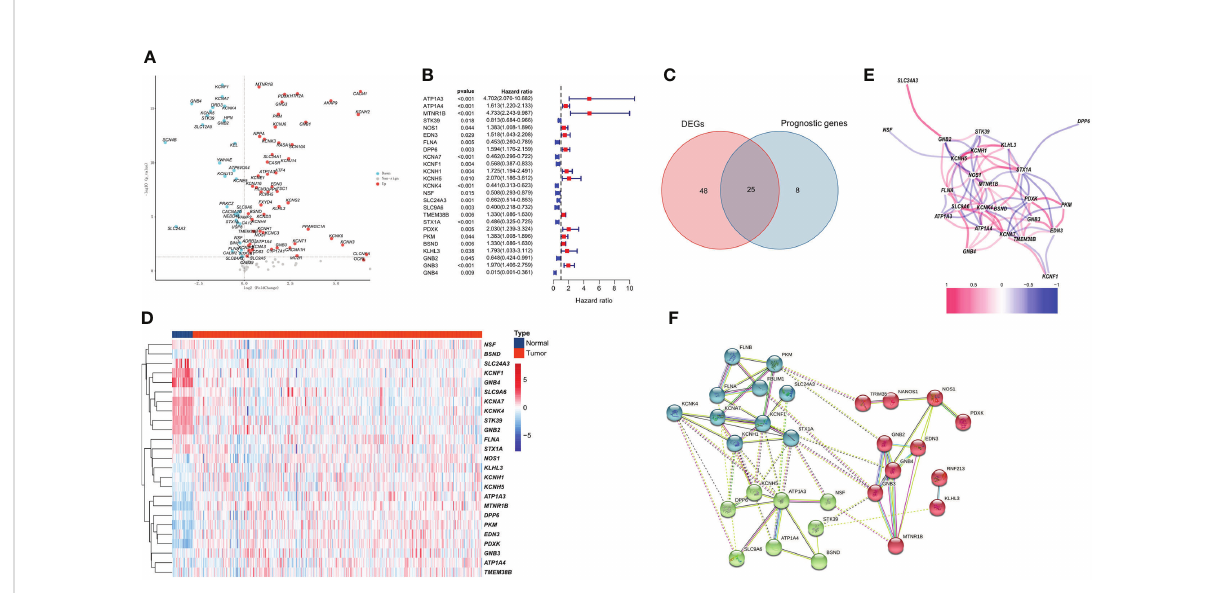
FIGURE 1 Identi fi cation of 25 prognosis-associated differentially expressed PCRGs. (A) Volcano plot of DEGs between ccRCC and normal tissues. (B) Univariate Cox analysis of 25 differentially expressed PCRGs in ccRCC. (C) Venn diagram showing the intersection of the DEGs and prognostic genes. (D) Heatmap illustrating the differential expression of 25 prognosis-associated PCRGs between ccRCC tissues and normal tissues. (E) Correlation between 25 differentially expressed PCRGs in the TCGA-KIRC cohort. Red represents a positive correlation, and blue represents a negative correlation. (F) PPI network of 25